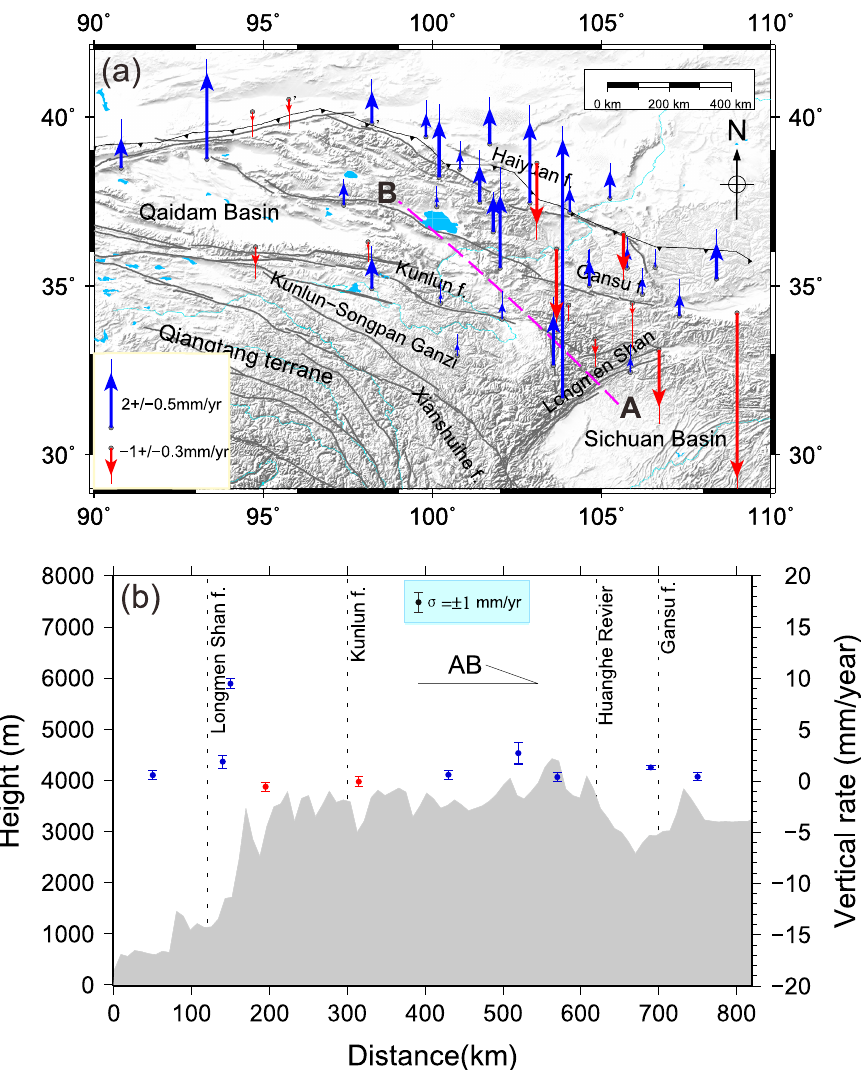
Figure 7. ( a ) the vertical crustal deformation rates in northeastern Tibet without the loading effect (from GRACE). Blue vectors denote uplift, and red vectors denote subsidence. The active faults in Tibet are marked by gray lines, and the black lines with triangles show two subduction belts in the northern and southern boundaries of Tibet; ( b ) profile charts showing the terrain height and uplift rate of the northeast Tibetan Plateau, the magenta dotted line from A to B in ( a ). The blue dots with error bars denote GPS sites with positive uplift rates and the red dots denote negative rates. The error bars represent one standard deviation on either side of the plotted points.